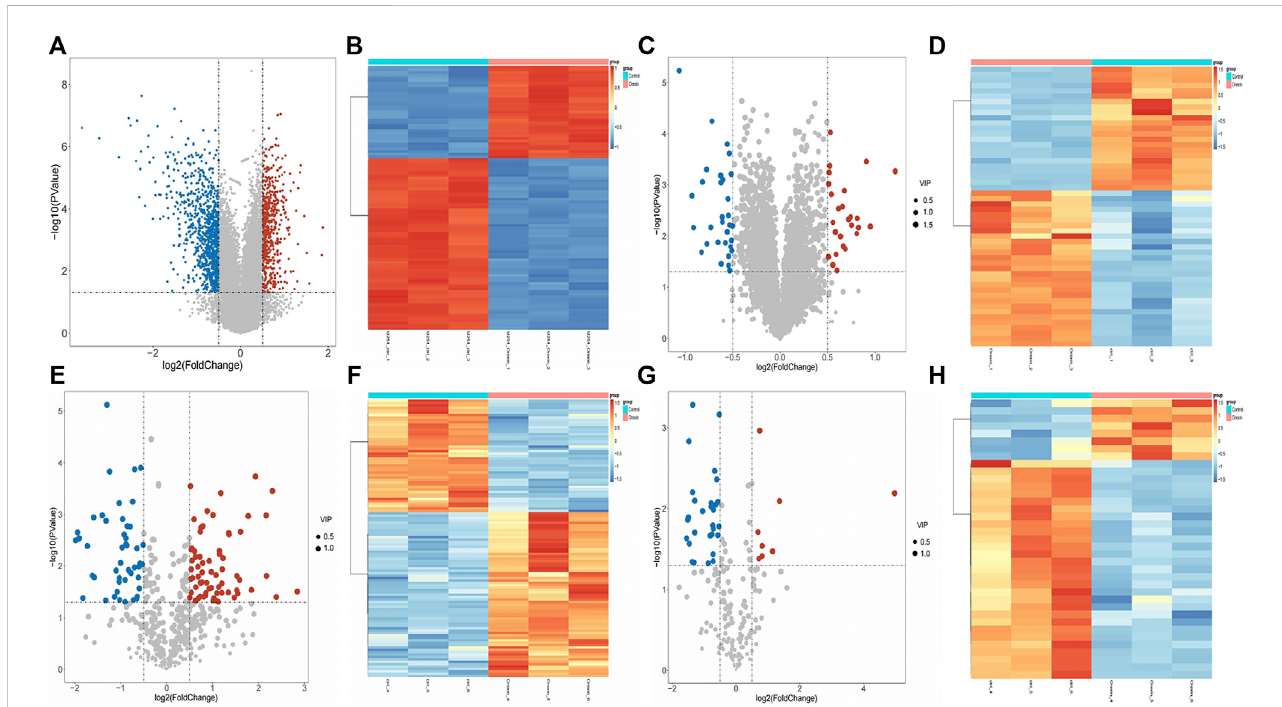
FIGURE 1 Differential expression analysis between case and control samples. (A) Volcano plots of differentially expressed genes (DEGs) between case and control samples with |log 2 fold change (FC)| > 0.5 and p -value < 0.05. (B) Heat map plots of the top 100 DEGs. (C) Volcano plots of differentially expressed proteins (DEPs) with |log 2 FC| > 0.5, p -value < 0.05, and VIP > 1. (D) Heat map plots of the top 100 DEPs. (E – F) Volcano plot and heatmap of differentially expressed metabolites (DEMs) with |log 2 FC| > 0.5, p -value < 0.05, and VIP > 1 in positive mode. (G – H) Volcano plot and heatmap of DEMs with |log2FC| > 0.5, p -value < 0.05 in negative mode. In the volcano plots, the red points represent upregulated genes, proteins, and metabolites, while the blue points represent downregulated genes, proteins, and metabolites. In heat map plots, the red point represents upregulated molecules, while the blue point represents downregulated